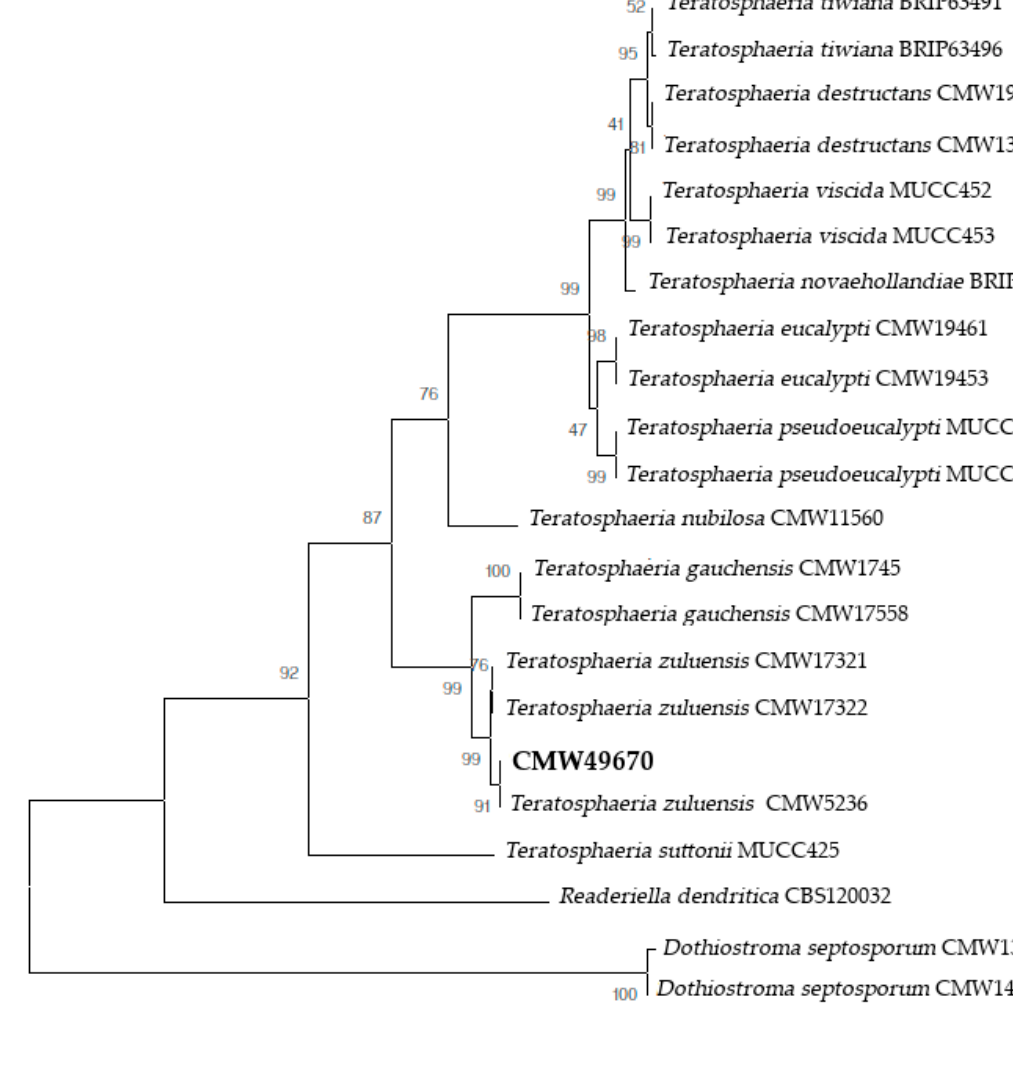
Figure 3. Maximum likelihood tree of Teratosphaeria canker isolates from Paraguay based on the combined analysis of ITS and the BT2 regions. Isolates and their culture collection names are indicated as CBS (Dutch Centraalbureau voor Schimmelcultures), CMW Fungal Culture Collection at FABI, MUCC (Murdoch University culture collection) and BRIP (Biosecurity Queensland Plant Pathology Herbarium), respectively. Bootstrap confidence values (1000 replicates) are indicated above the internodes. The tree was rooted in Dothiostroma septosporum.